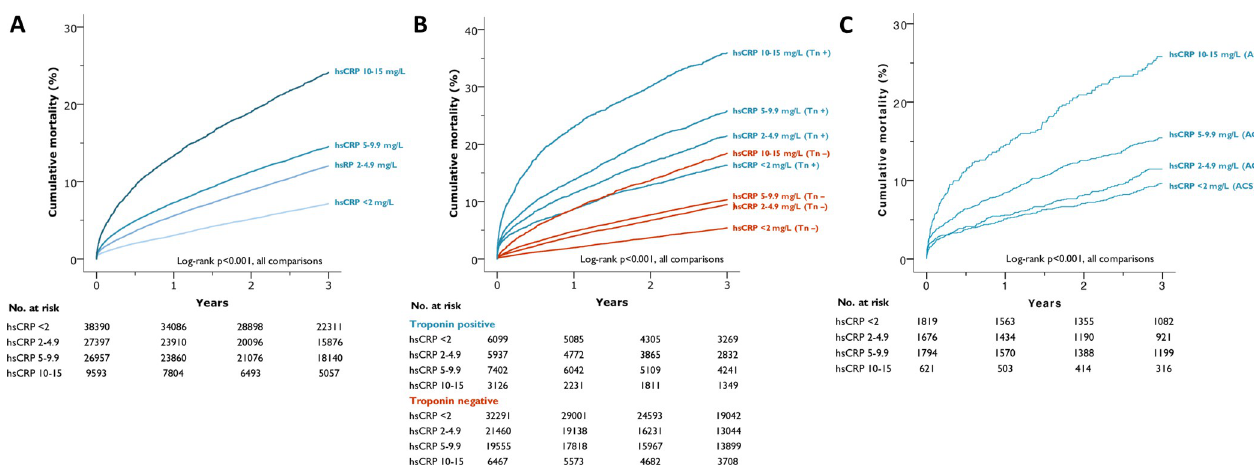
Fig 2. Unadjusted Kaplan–Meier mortality curves by (A) hsCRP level, (B) hsCRP level and troponin positivity, and (C) hsCRP level in a subgroup of patients with ACS. ACS, acute coronary syndrome; hsCRP, high-sensitivity C-reactive protein; Tn +, troponin positive, Tn − , troponin